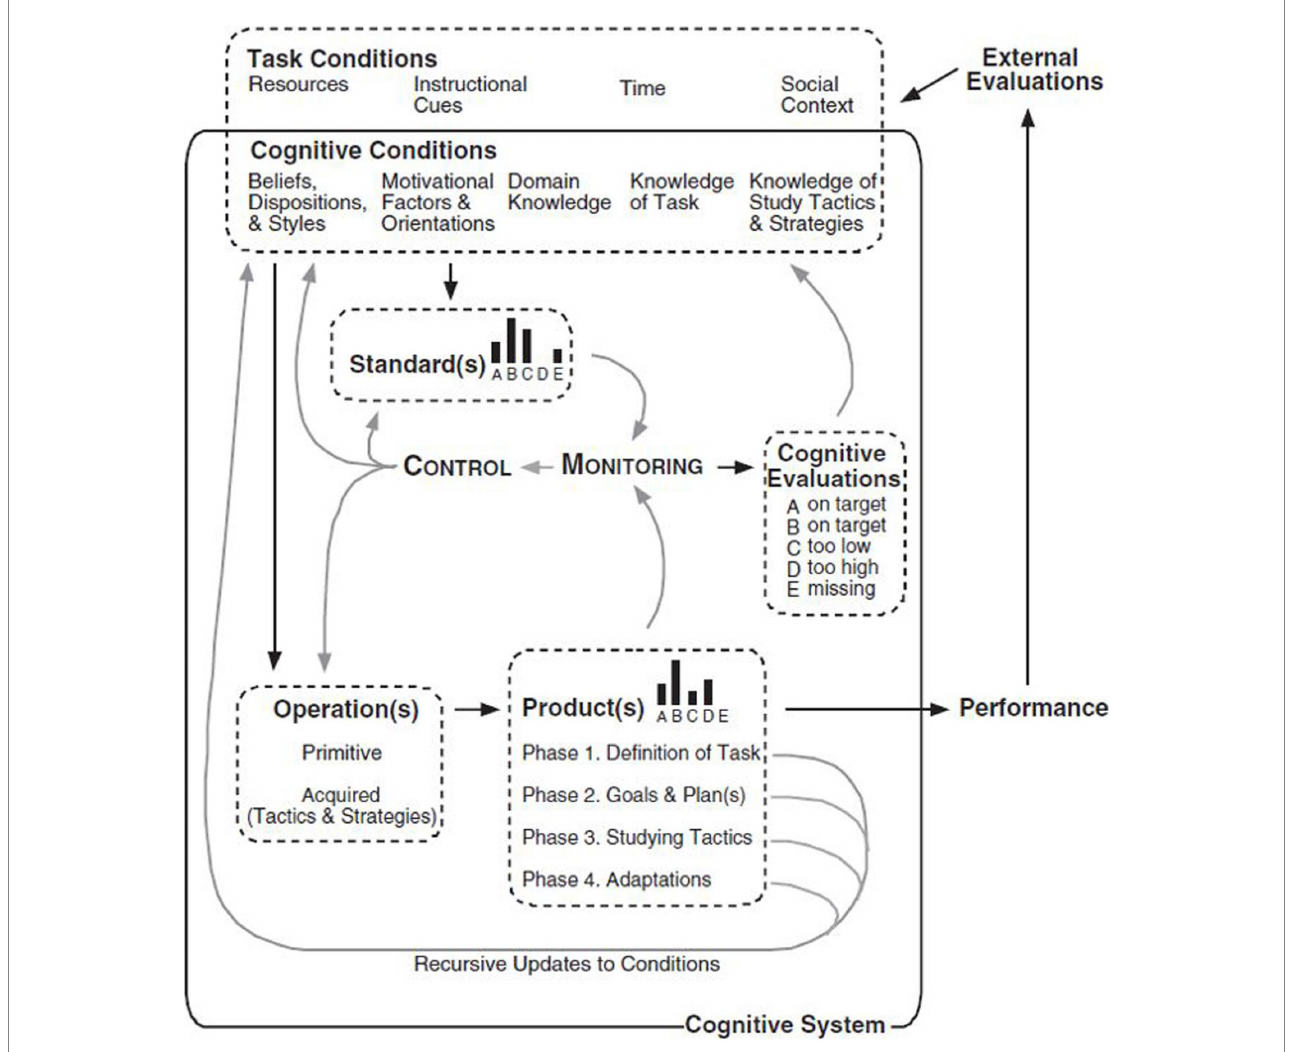
FIGURE 1 Winne and Hadwin's (1998) model of self-regulated learning from Perry and Winne (2006) learning from Learning Kits: gStudy Traces of Students Self- Regulated Engagement with Computerized Content (p. 213). Educational Psychology Review , 18,